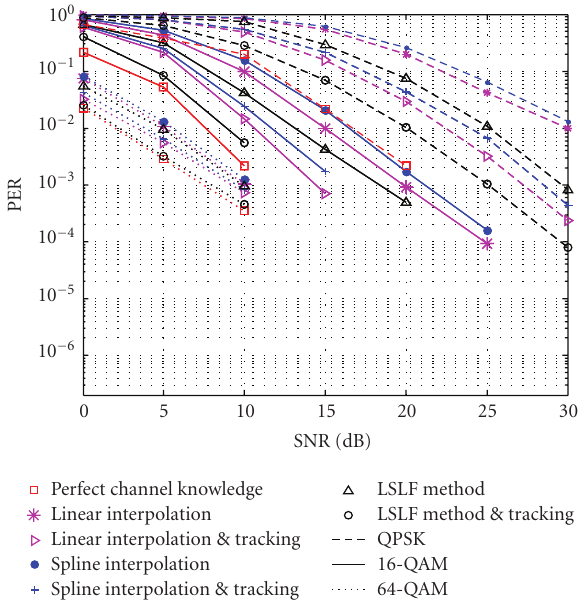
Figure 8: PERs in Veh.A 120 km/h.